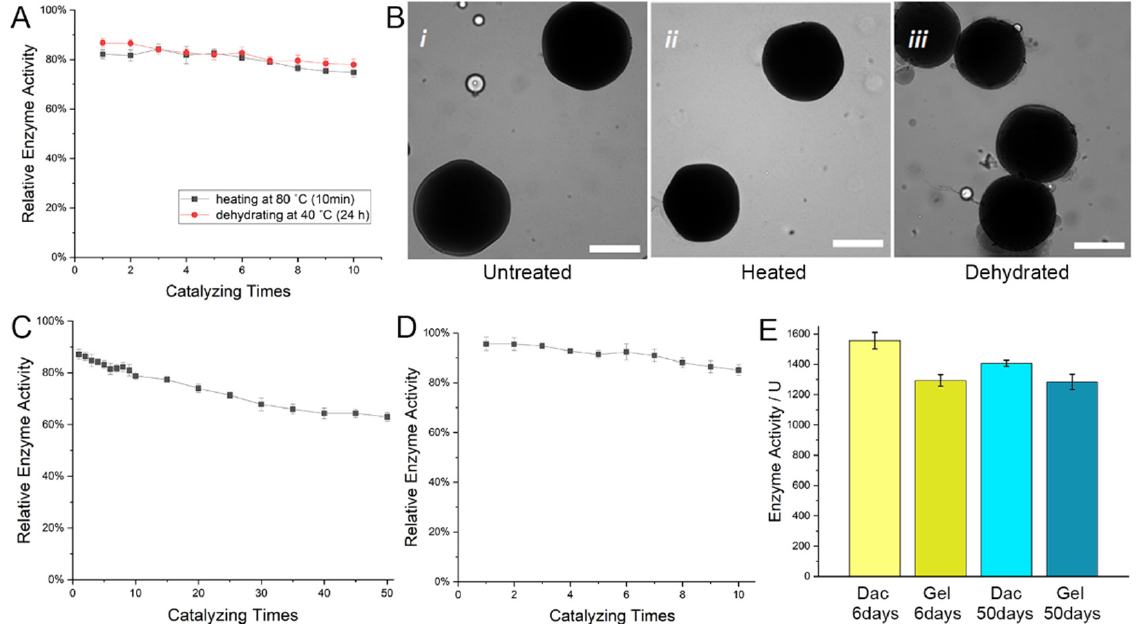
Figure 4. Relative enzyme activities and images of hydrogels with heating, dehydrating, massive recycling, and long-time storing. ( A ) Relative enzyme activities of hydrogels with the treatments of heating at 80 ◦ C for 10 min and dehydrating at 40 ◦ C for 24 h. Crude Dac solution (free enzyme) was used as the reference of enzyme activity, the same below. ( B ) Images of hydrogels for no treatment ( i ), heating treatment ( ii ), and dehydrating treatment ( iii ) under microscope. Scale bars are 100 µ m. ( C ) Relative enzyme activities of the optimized hydrogel with 50 rounds of catalyzing. ( D ) Relative enzyme activities of the optimized hydrogel after storing for 50 days. ( E ) Enzyme activities of the optimized hydrogel and crude Dac solution before and after the storing for 50 days. Note: preparation of hydrogel took 6 days.